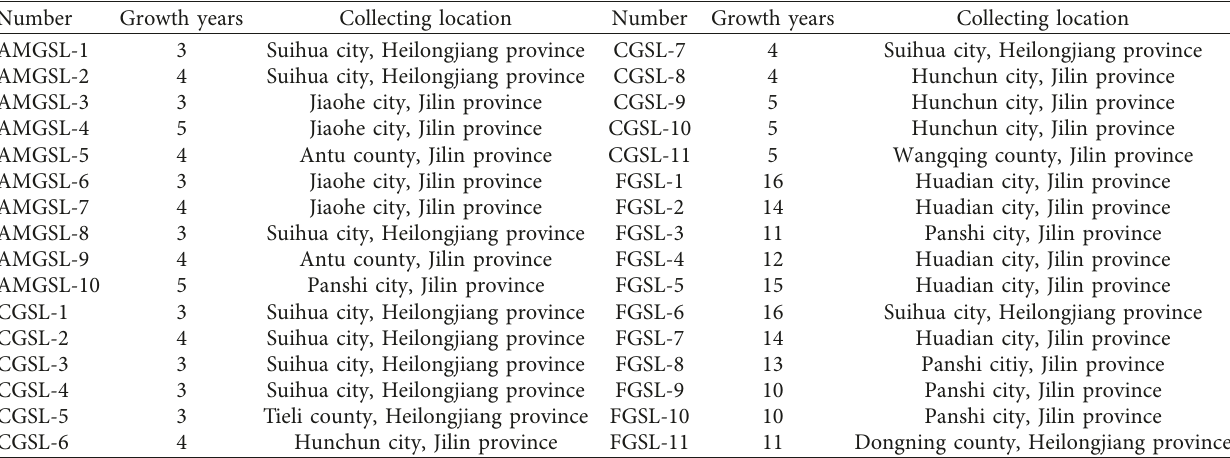
Table 2: The information about growth years and collecting location for all Panax genus stem-leaf